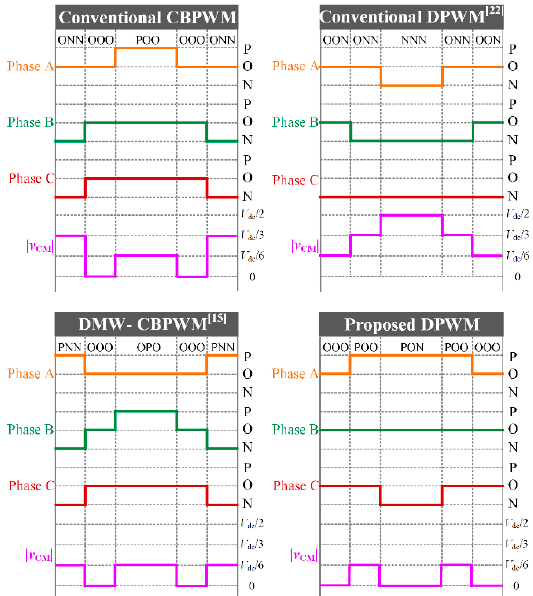
Figure 13. Switching sequences and the corresponding CMV in a unit carrier period for the four tested strategies.